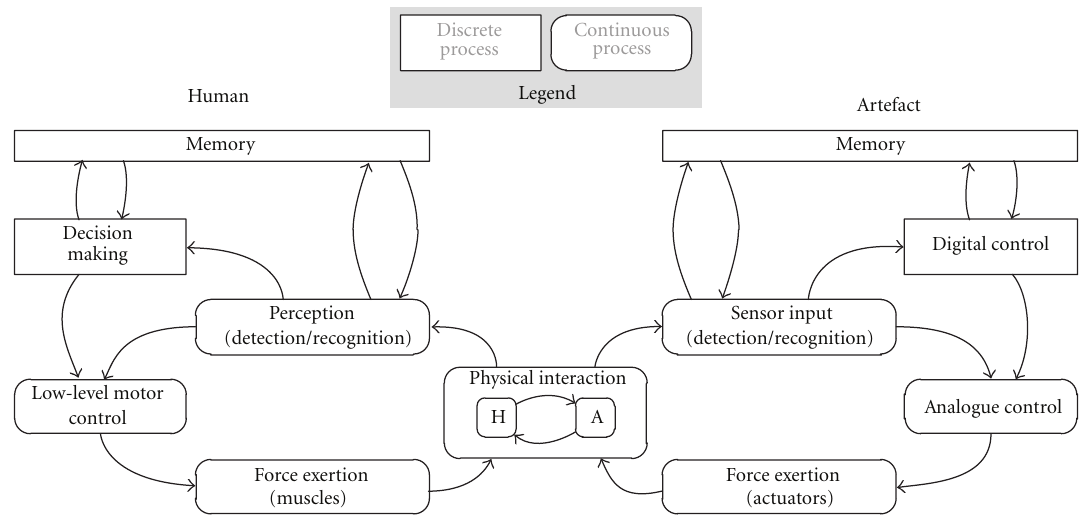
Figure 4: Simplified reasoning model of control loops in human-artefact interaction (further elaboration of Figure